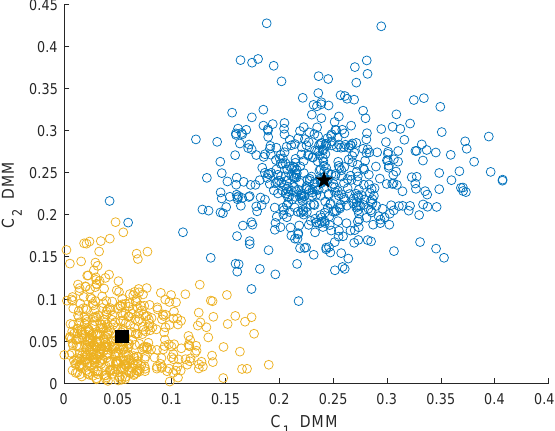
Figure 3. Clustering effect of the differences between maximum and minimum eigenvalue (DMMs) under the Rayleigh channel.